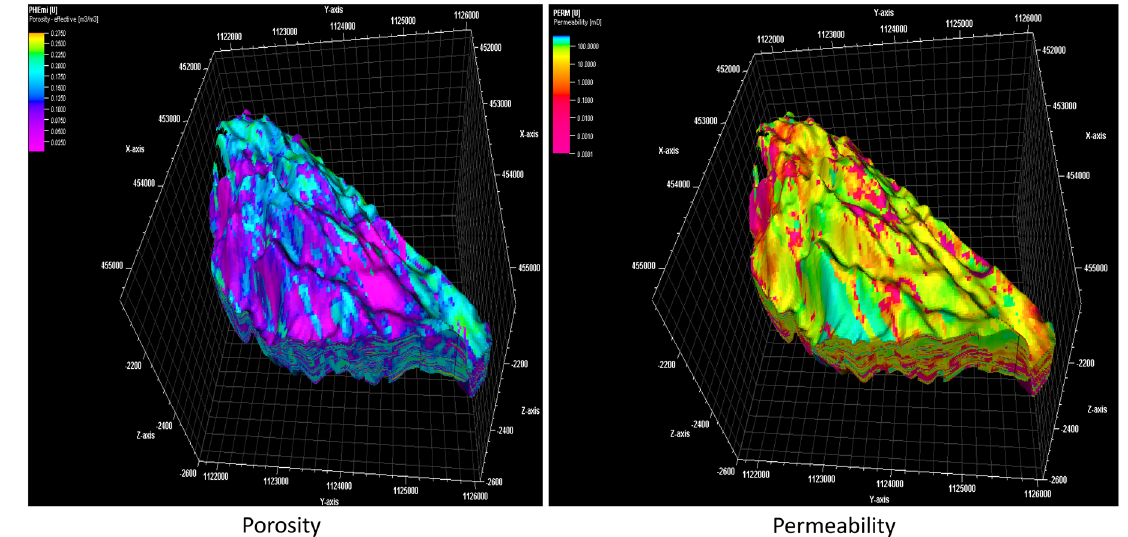
Fig. 9 The reasonable porosity and horizontal permeability models for this